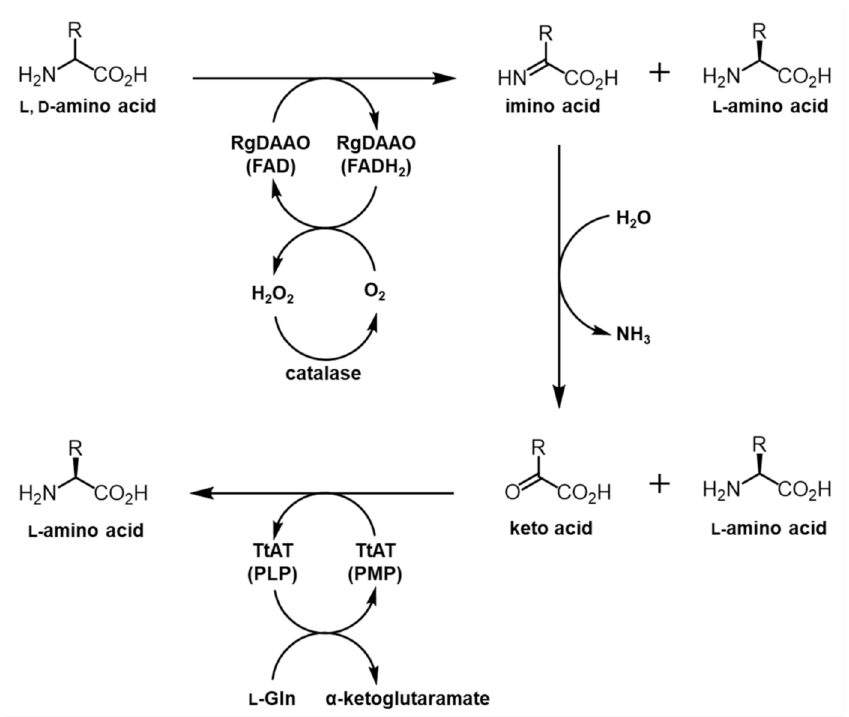
Figure 2. Overall scheme of the coupled enzyme system for conversion of racemic amino acids into their optically pure forms. RgDAAO oxidizes the D -form of a racemic amino acid into the α -keto acid, which is subjected to the transamination by TtAT to produce the L -form of an amino acid. The final product of this process is an optically pure L -form amino